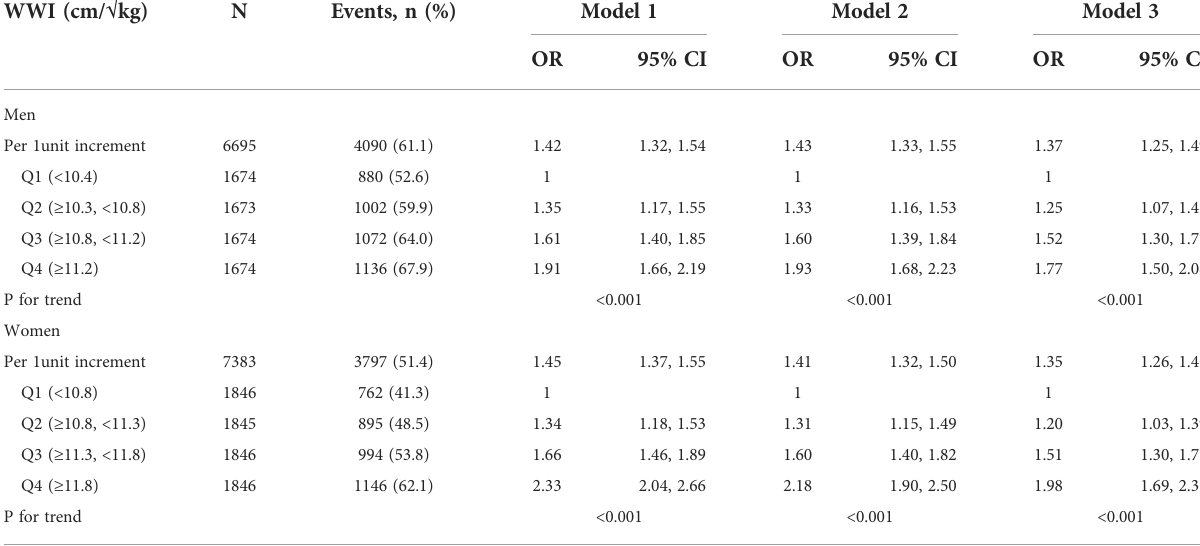
TABLE 2 Association between the weight-adjusted-waist index and hyperuricemia in different models. WWI (cm/ √ kg) N